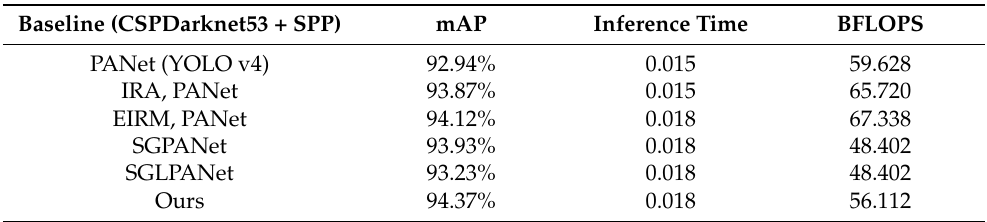
Table 4. Ablation experiment. SGPANet represents use SandGlass block. SGLPANet mean uses SandGlass-L block.IRA is the Inception